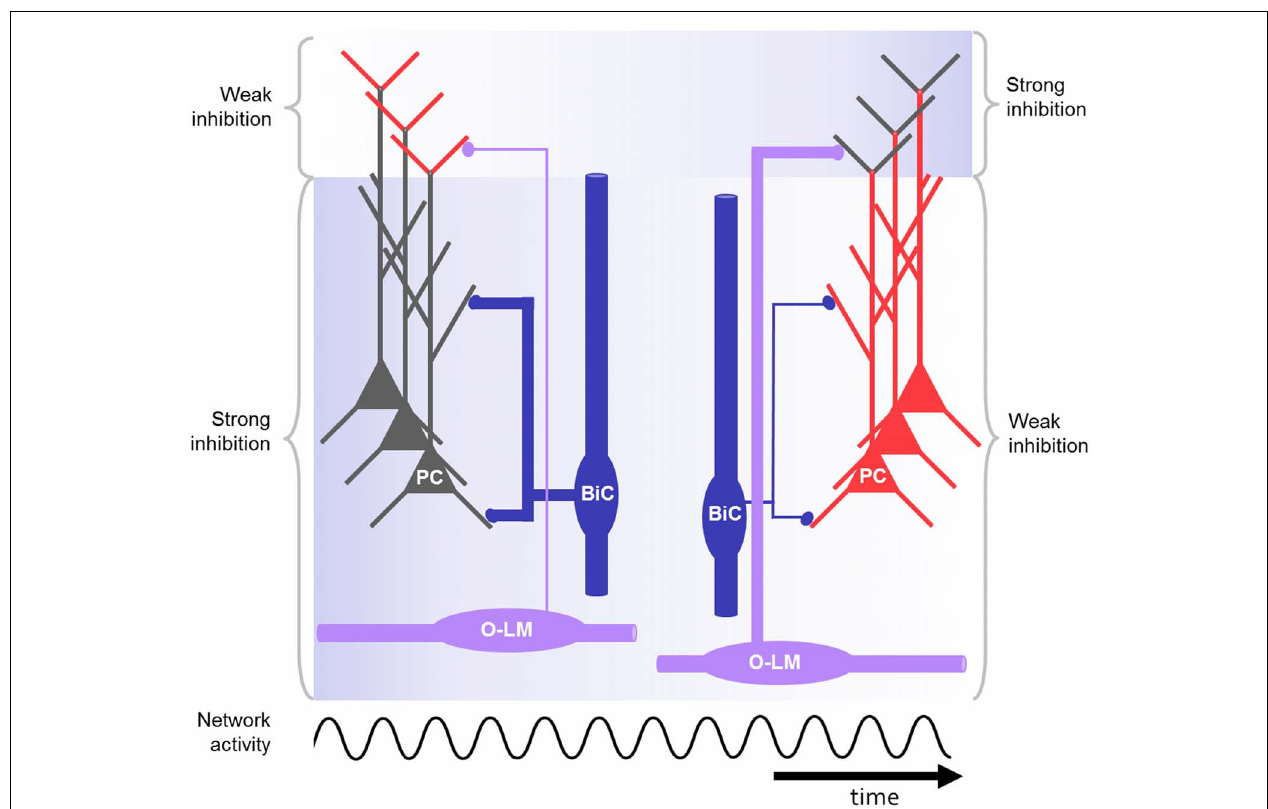
FIGURE 3 | Schematic drawing of CA1 microcircuit including O-LM and bistratified interneurons during oscillations, e.g., at gamma or theta frequency. The bistratified interneuron strongly inhibits the proximal dendrites of the pyramidal cell at the beginning (blue background) and is losing its impact during repeated activation of the network. In contrast, the O-LM interneurons display low output at the beginning but gain